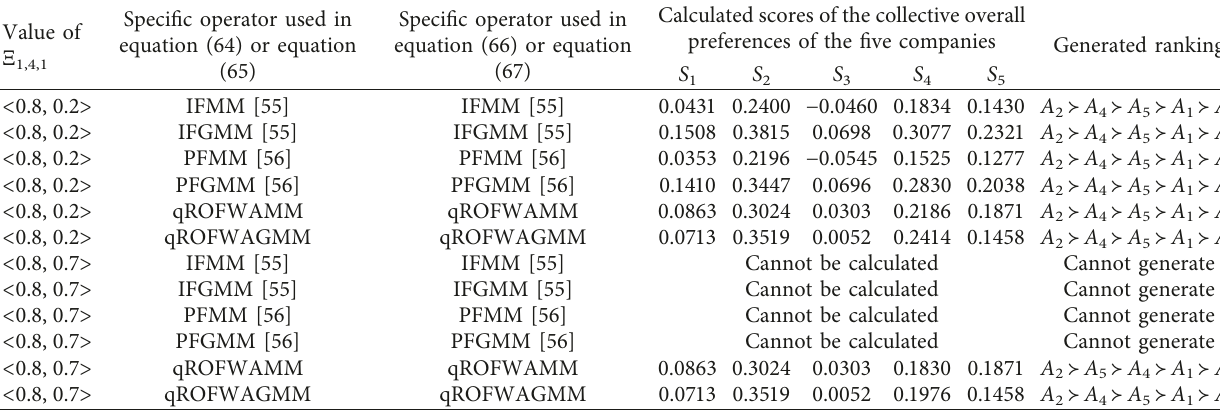
Table 4: The results of the quantitative comparison with the MCGDM methods based on Muirhead aggregation operators of IFNs and PFNs. Notes: when comparing the proposed method, the qROFWAHMM and qROFWAHGMM operators were selected. When adapting the groups of IFMMs, IFGMMs, PFMMs, and PFGMMs, Δ � ( δ 1 , δ 2 , δ 3 ) � (1, 0, 0) for IFMM and PFMM in equation (64) and IFGMM and PFGMM in equation (65), and Δ � ( δ 1 , δ 2 , δ 3 ) � (1, 2, 3, 4) for IFMM and PFMM in equation (66) and IFGMM and PFGMM in equation (67). When adapting the groups of qROFWAHMMs and qROFWAHGMMs, q � 3, λ � 3, and Δ � ( δ 1 , δ 2 , δ 3 ) � (1, 0, 0) for qROFWAHMM in equation (64) and qROFWAHGMM in equation (65), and q � 1, λ � 3, and Δ � ( δ 1 , δ 2 , δ 3 ) � (1, 2, 3, 4) for qROFWAHMM in equation (66) and qROFWAHGMM in equation (67). Calculated scores of the collective overall preferences of the five companies Generated ranking